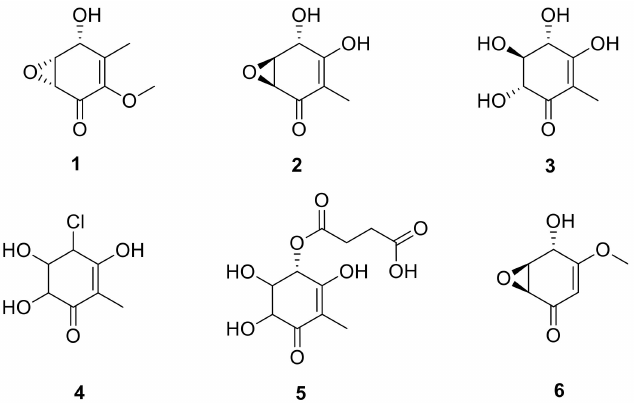
Figure 1. Structures of cyclohexenones: cyclobotryoxide, ( − )-terremutin, (+)-terremutin hydrate, 4- chloro-terremutin hydrate, (+)-4-hydroxysuccinate-terremutin hydrate, (+)- epi -sphaeropsidone ( 1–6